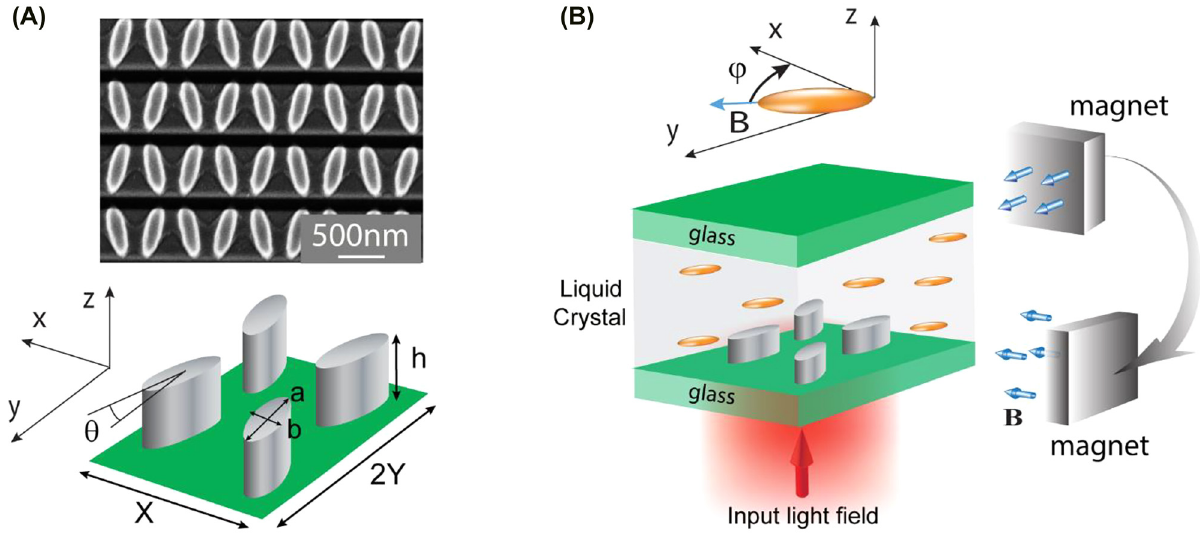
Figure 1: Magnetic tuning of dielectric metasurface integrated into the NLC cell: (A) Scanning electron micrograph of the fabricated metasurface. The insert below shows a sketch of dielectric metasurface that is composed of zigzag arrays of elliptical silicon cylinders with parameters 𝜃 = 15 ◦ , X = 900, Y = P nanometers). (B) Schematic illustration of the metasurface integrated into an NLC cell. The NLC molecules’ arrangement is defined by the direction of applied magnetic field B at the azimuthal angle 𝜑 in-plane x – y . We consider a uniform field strength and, as a result, a homogeneous distribution of n in the